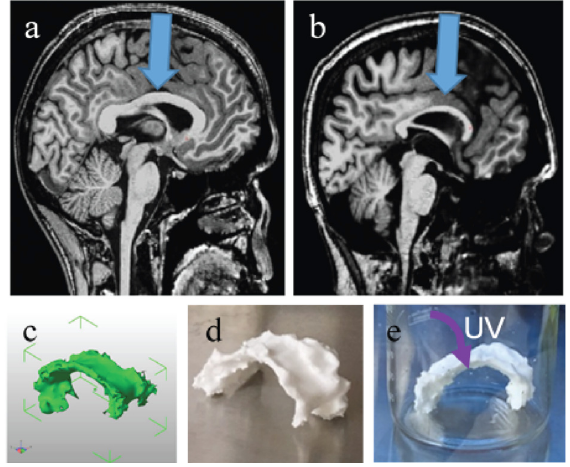
Figure 1. 3D models and prints. ( a – b ) T1-weighted brain MRI with resolution of 1×1×1 mm, midsagittal slice, arrow pointing at corpus callous in ( a ) healthy control and ( b ) MPS I subject. ( c ) CAD image of MPS I corpus callosum taken at five adjacent slices in each hemisphere. ( d ) 3D printed MPS I corpus callosum with poly(lactic-acid) on a Makerbot Replicator 5X. ( e ) UV sterilizing the print